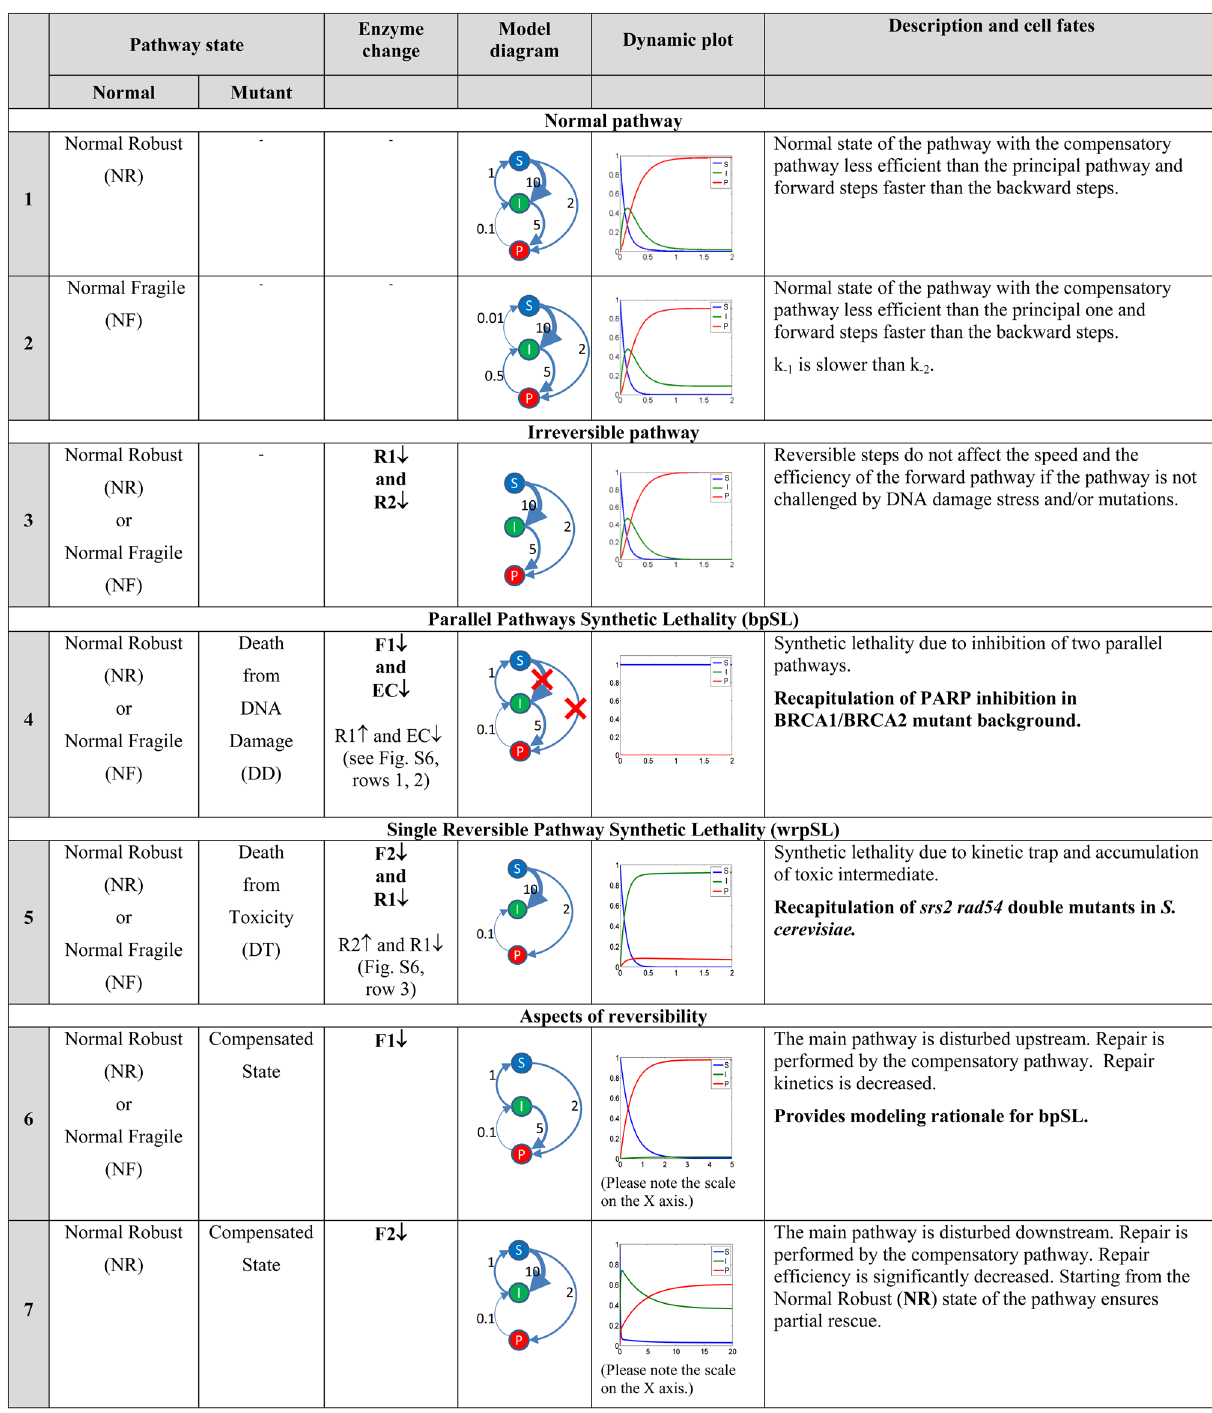
Figure 6. Modeling possible scenarios of single and double synthetic lethal mutations. Pathway steady states depicted as Normal states ( N ) as Normal Robust ( NR ) and Normal Fragile ( NF ); Mutant states ( M ) as compensated state dependent on compensatory pathway EC( C ); death from DNA damage ( DD ) and death from toxicity ( DT ). Dynamic plots show prediction of model for evolution of substrate ( S ), intermediate ( I ) and product ( P ) amounts over time corresponding to the choice of kinetic parameters shown on the Model diagram . ( X-axis )-time, ( Y-axis )- substances level. F1 , F2 , R1 , R2 , and EC refer to the enzymes catalyzing the two forward and two backward reactions as well as the compensatory pathway, respectively (see Figure 3). ( Q )-complete knock-down or mutational loss of function; ( q )-over-expression. A deletion mutant was simulated by setting the corresponding kinetic rate constant to zero. An overexpression mutant was simulated by setting the corresponding kinetic rate constant sufficiently high to have a qualitative effect onto the steady state or the dynamics in the simulations. Some double mutants are not shown due to their triviality (such as F1 Q F2 Q ) or difficulties with interpretation (such as F1 Q R1 Q ). For more modeling scenarios see Figure S5 in Text S1.